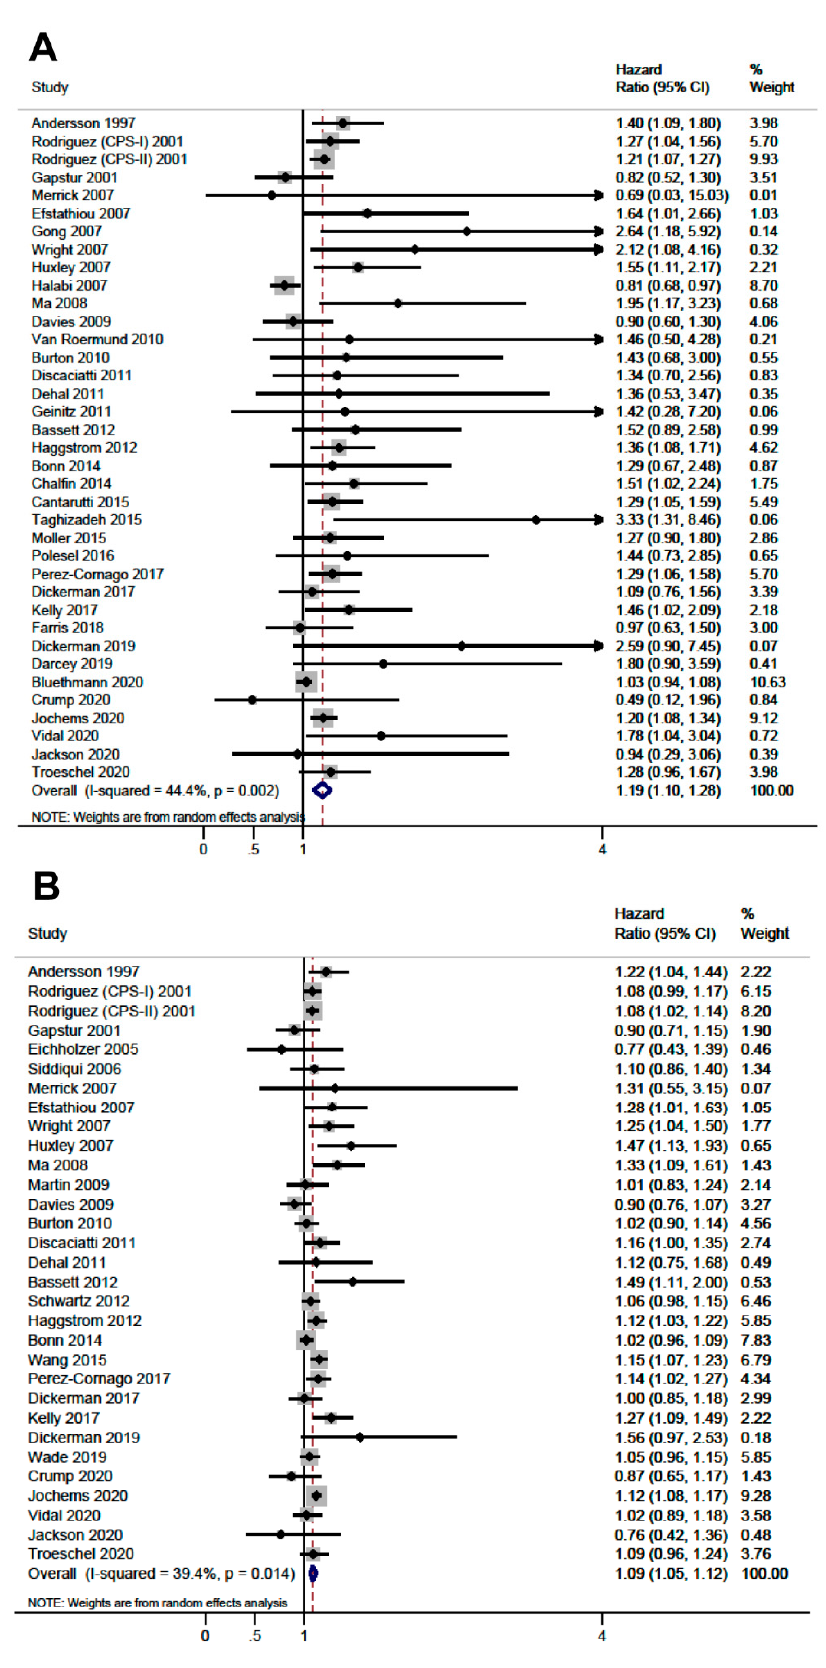
Figure 3. Forest plots of the association for prostate cancer specific mortality. ( A ) Obesity (body mass index ≥ 30 kg/m 2 ) compared to normal weight (body mass index < 25 kg/m 2 ). ( B ) Continuous body mass index per 5 kg/m 2 increment.